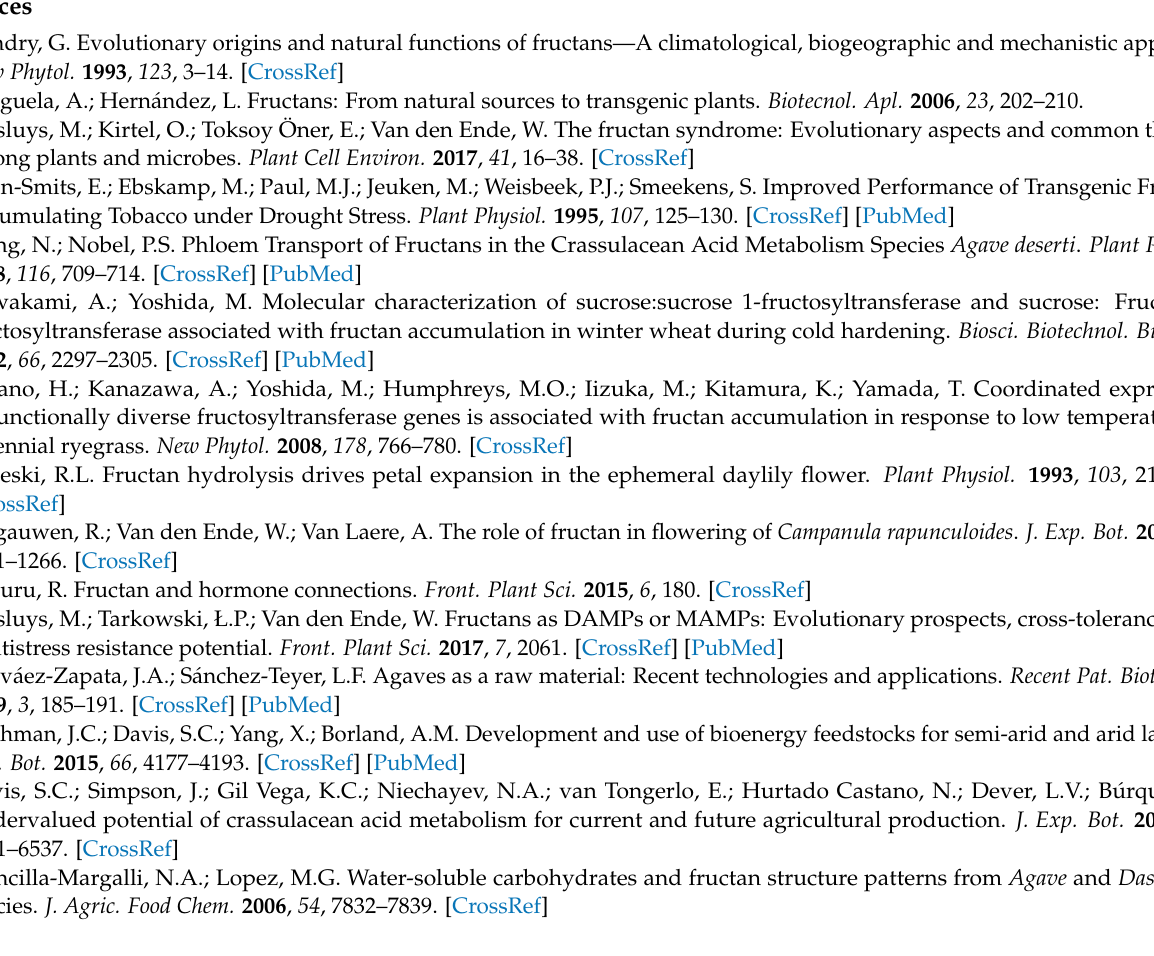
phylogenetic analyses; Table S3: Gene structure conformation of PGHF32 genes in monocotyledonous and dicotyledonous species; Table S4: Nucleotide conformation in exons and introns of genes encoding the PGHF32 enzymes in Agave tequilana